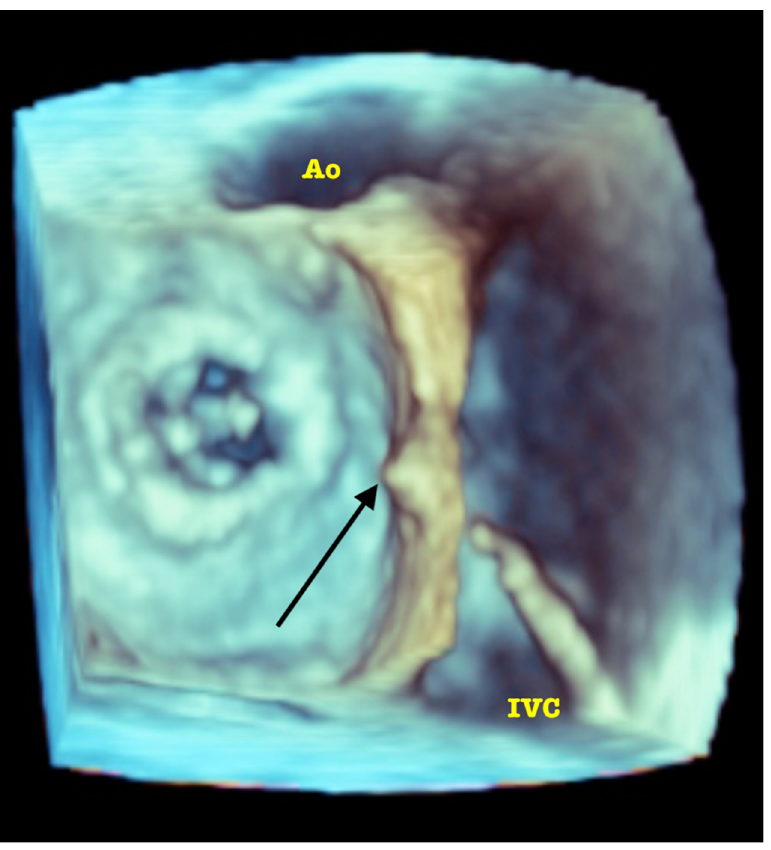
Figure 4. 3D TOE volume rendering visualization of the interatrial septum tenting (black arrow) produced by the tip of transseptal sheath (IVC: inferior vena cava; Ao: aortic root).